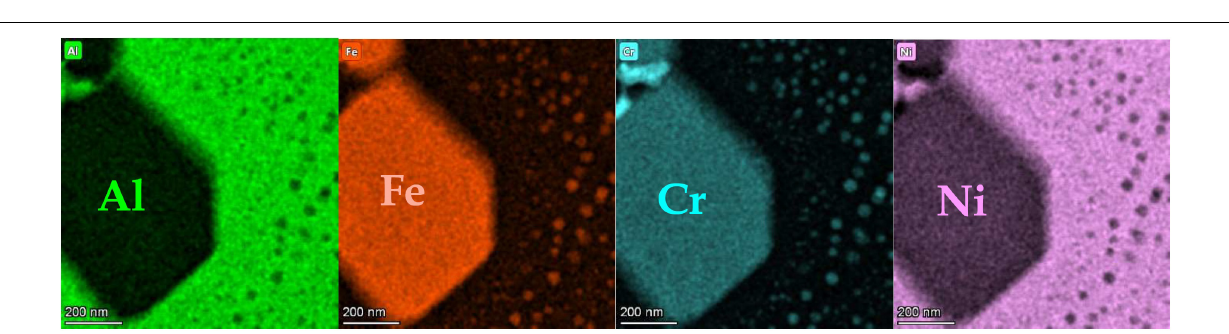
Frontiers in Materials |